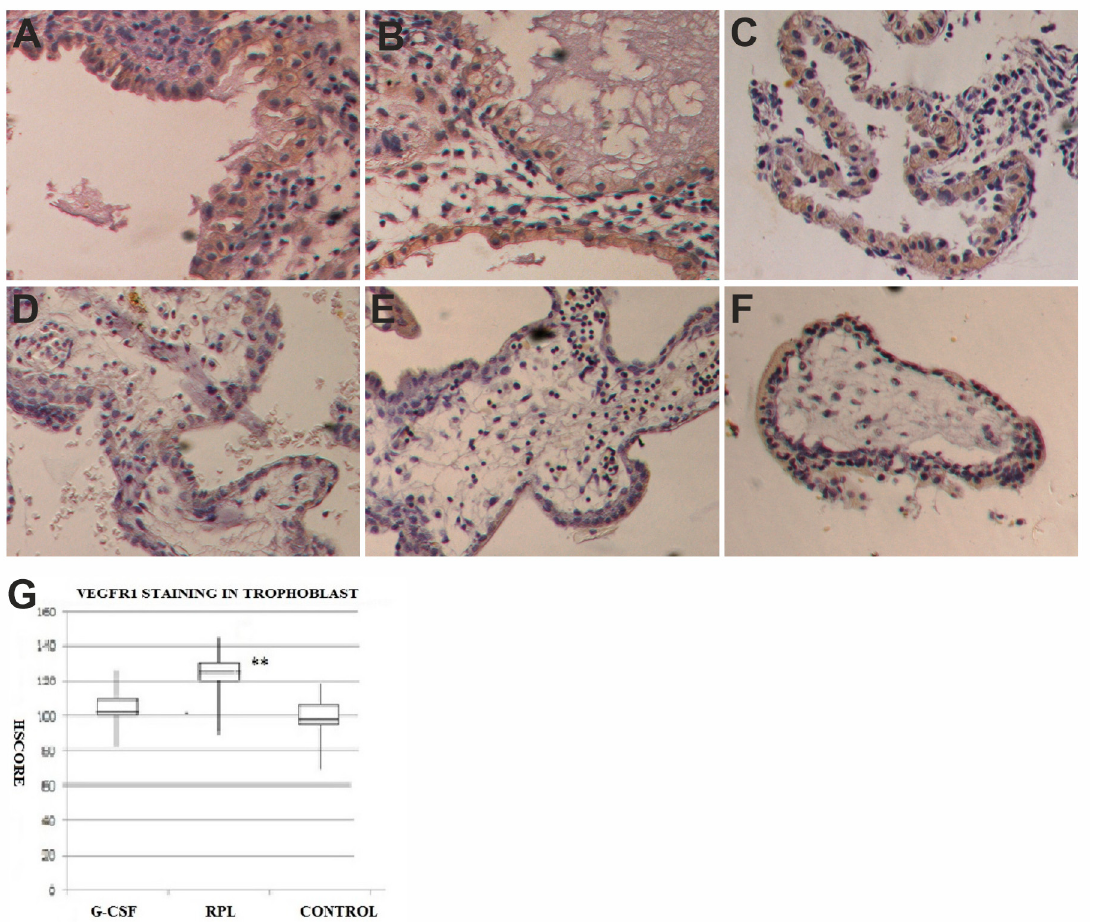
Figure 5. VEGFR-1 expression in decidua and trophoblast of first trimester pregnancy. In decidua of G-CSF treated group ( A ), in the no treated RPL group ( B ) and Control pregnancies ( C ) there was the same staining levels in the epithelial cells but no in the stroma for VEGFR-1 (brown color) (400 × ). In trophoblast of G-CSF treated samples ( D ), the syncytiotrophoblast was moderately positive to VEGFR-1 (brown color) (400 × ). In trophoblast of RPL no-treated samples ( E ), the syncytiotrophoblast was strongly positive to VEGFR-1, more than in other two groups (400 × ). In trophoblast of Control samples ( F ), the syncytiotrophoblast was moderately positive to VEGFR-1 (brown color) similar to G-CSF treated samples (400 × ). The graph ( G ) showed immunohistochemical staining semi quantitative HSCORE for VEGFR-1 (Charts display median and quartiles with whiskers showing the range): There was statistically significant di ff erences between G-CSF vs. RPL (* p < 0.001) and RPL vs. Control (** p < 0.001).